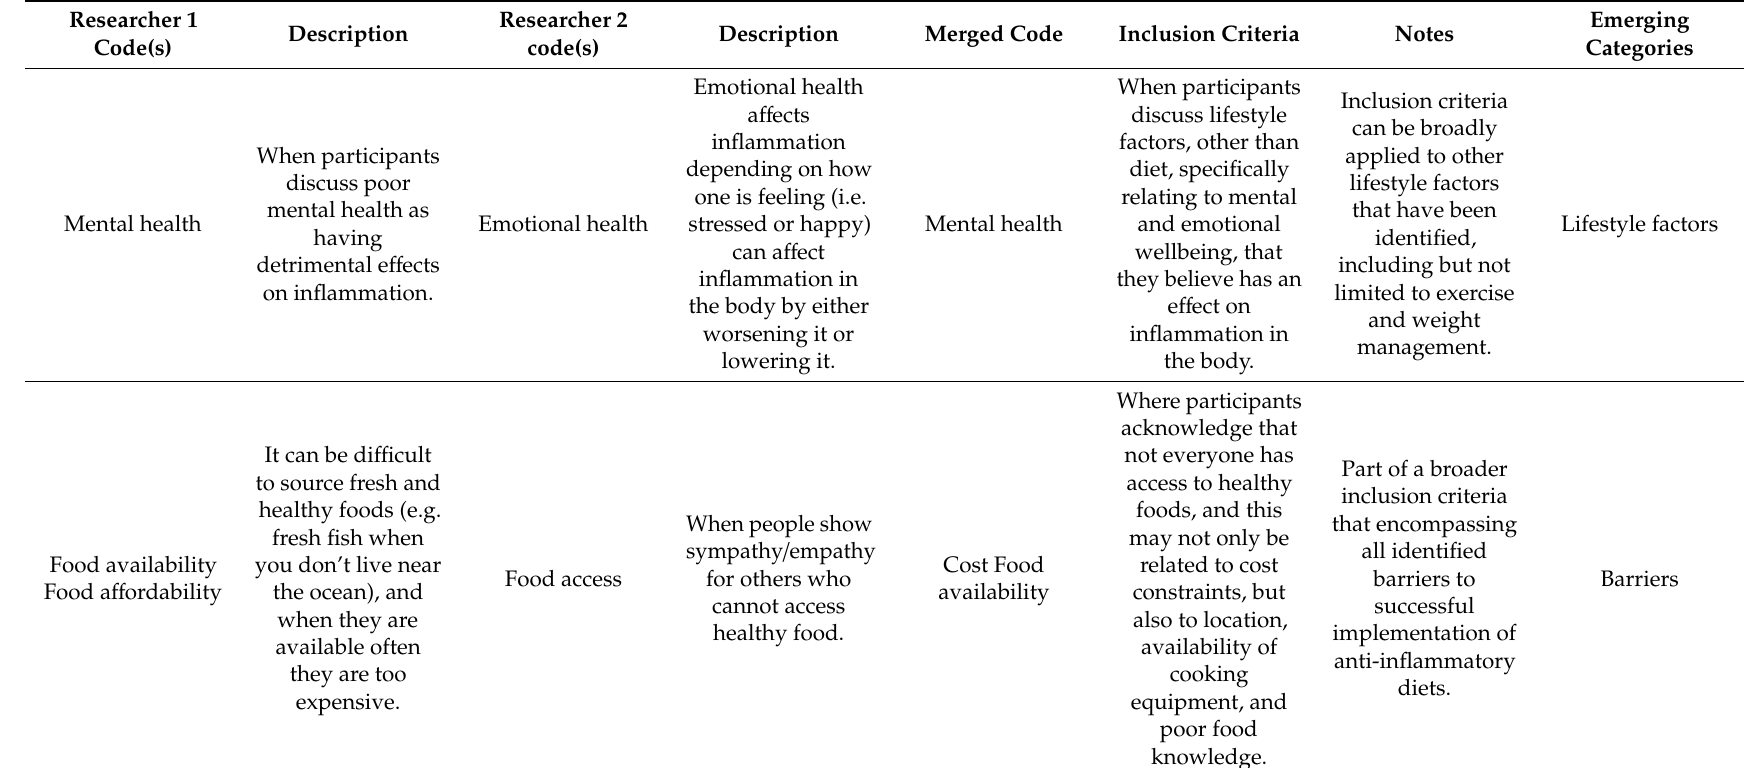
Table A3. Sample of the collaborative code development